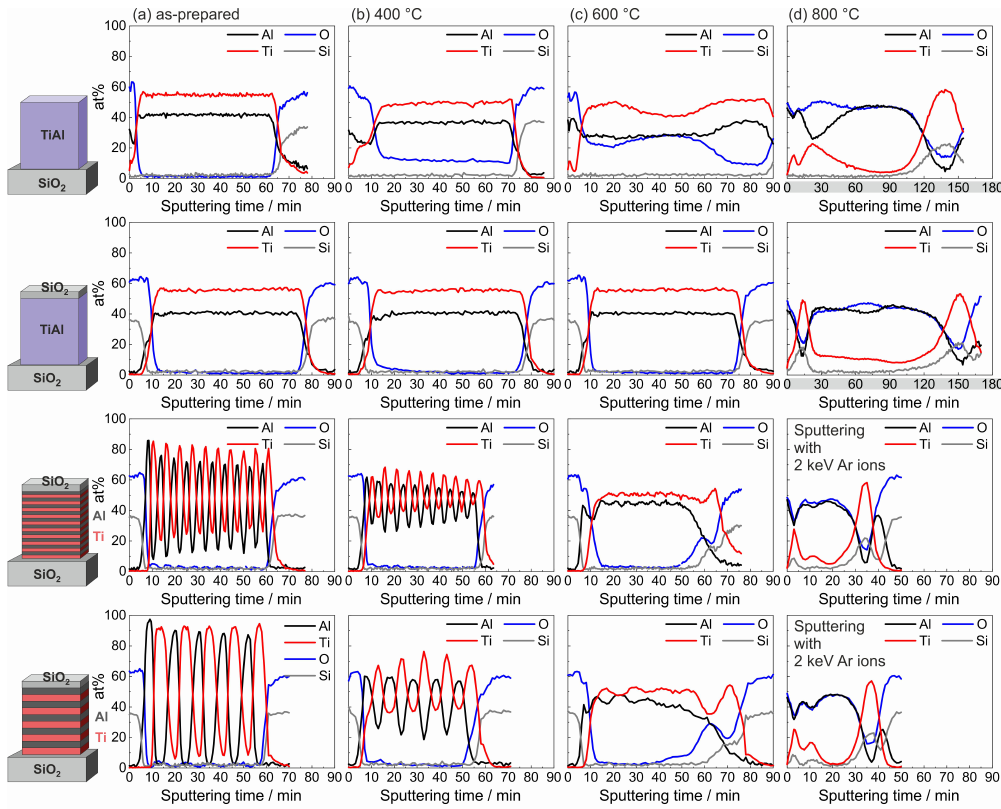
Figure 3. Results of the AES measurements of the co-sputtered Ti-Al film, co-sputtered Ti-Al film with SiO 2 cover layer, ML Ti/Al film with 10 nm and 20 nm individual layer thickness, both with SiO 2 cover layer in: ( a ) the as-prepared state; ( b ) after annealing at 400 ◦ C; ( c ) after annealing at 600 ◦ C; and ( d ) after annealing at 800 ◦ C. In ( d ), the gray contrast of the abscissa in the figures of the alloy samples points out the longer sputtering time as compared to the other graphs. In contrast to this, the sputtering of the ML samples was performed with a higher sputtering energy (2 keV instead of 1 keV), which resulted in a shorter total sputtering